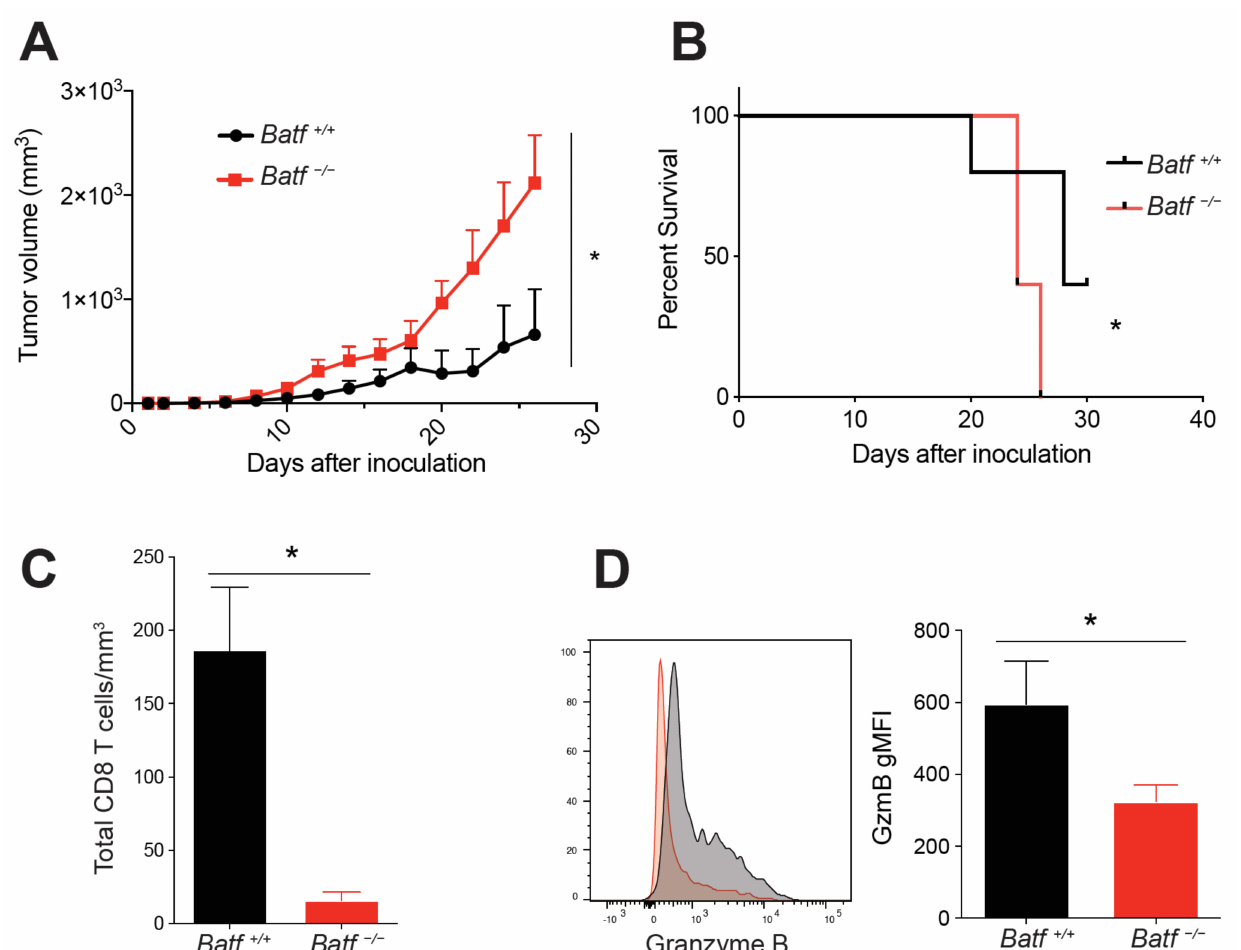
Figure 1. Basic Leucine Zipper ATF-Like Transcription Factor (BATF) is intrinsically required for effector function of tumor-infiltrating CD8 + T cells. Mixed bone marrow chimera mice were inoculated with B16 melanoma. Tumor (B16-F10) growth ( A ) and survival ( B ) were monitored over time ( n = 5). Mixed bone marrow chimera mice were inoculated with B16-GP33 tumors and then sacrificed 8–12 days later, once tumors were palpable. ( C ) Total CD8 + T cells/mm 3 of tumor, assessed via cell counts and flow cytometry ( n = 4–5 per group). The gating strategy is depicted in Figure S1. ( D ) Granzyme B mean fluorescence intensity (MFI) of activated (CD44 + ) tumor-infiltrating CD8 + T cells; representative histograms are shown ( n = 14 per group). (*, p -value <